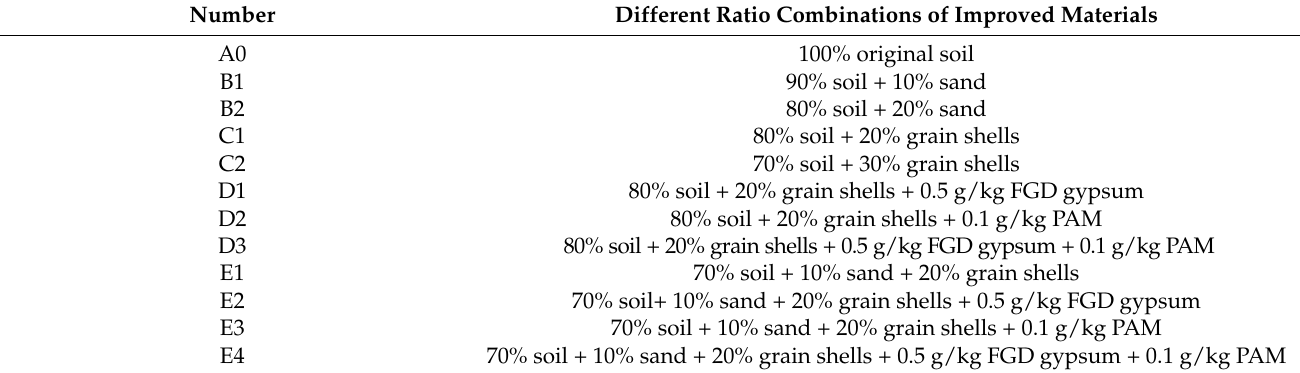
Table 3. Different proportioning schemes of modified materials.